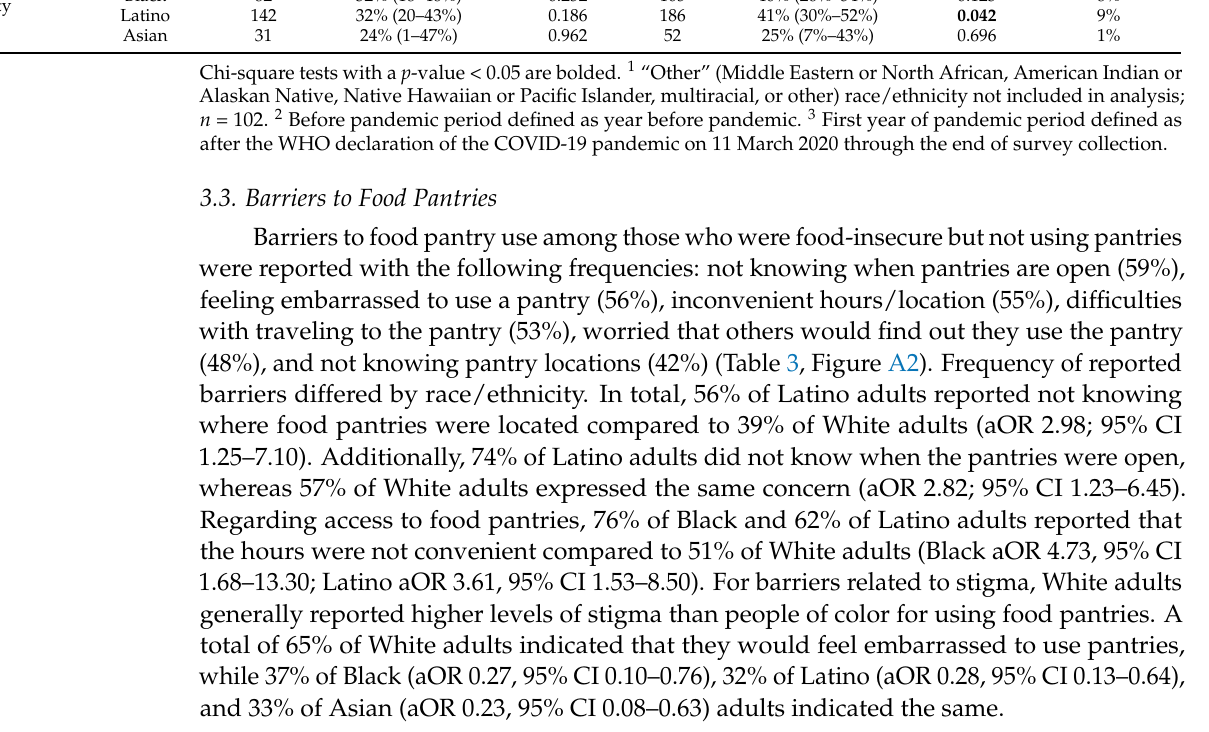
Table 3. Crude and adjusted odds ratios for statements pertaining to food pantry barriers by race, n =